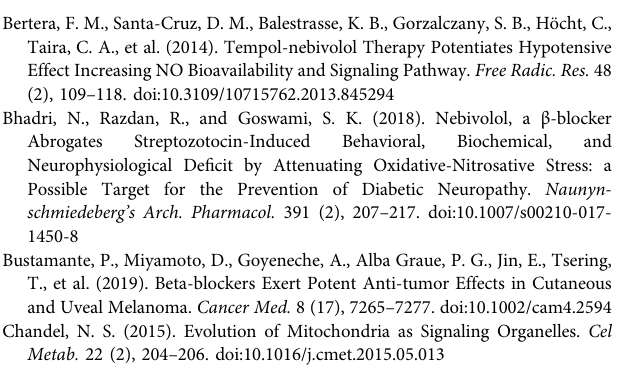
Frontiers in Pharmacology |